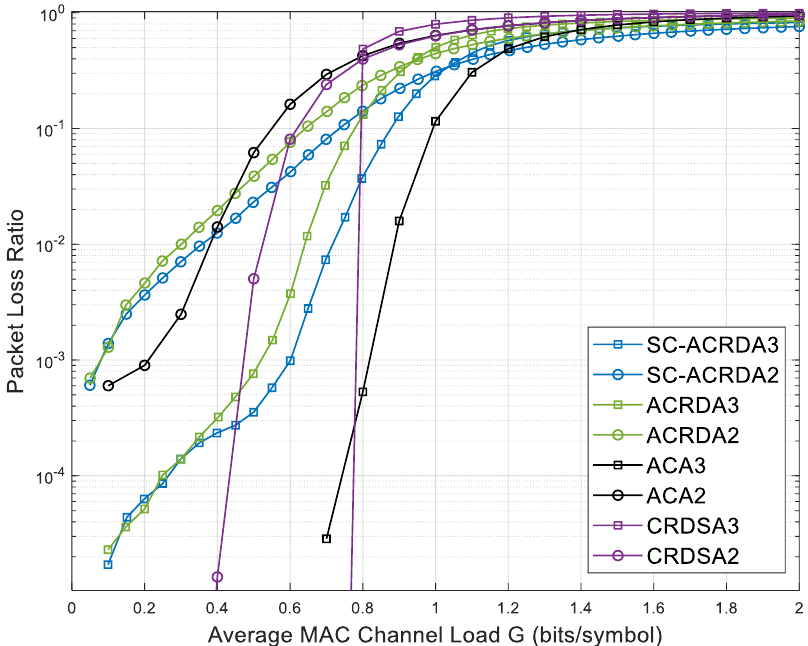
Figure 8. Comparison of PLR of SC-ACRDA2 and SC-ACRDA3 with other schemes.